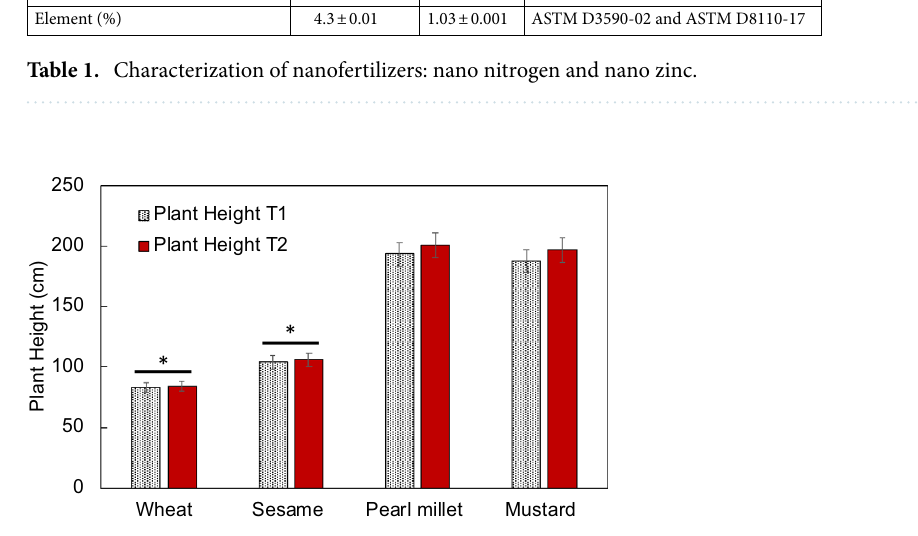
Figure 2. Effect on plant growth: comparison of plant height parameters of the tested crops which were grown under field condition with the treatments T1: conventional fertilizer and T: organic farming practice with nanofertilizer of nitrogen and zinc. T1 treatment-1, T2 treatment 2. *Non-significant difference between the